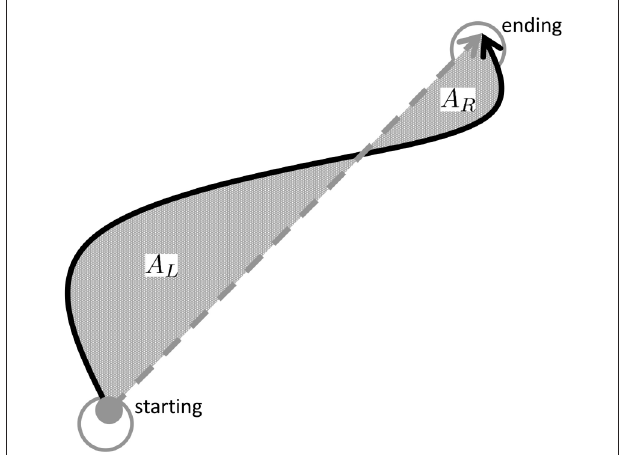
FIGURE 4 | Movement curvature is assessed by calculating the area enclosed to the left ( A L ) and to the right ( A R ) of the straight-line connecting the starting and ending of a movement. The total area A sum = A L + A R indicates whether movements are curved and the net area A net whether there is a tendency to veer more on the right ( A net > 0) or to the left A net <